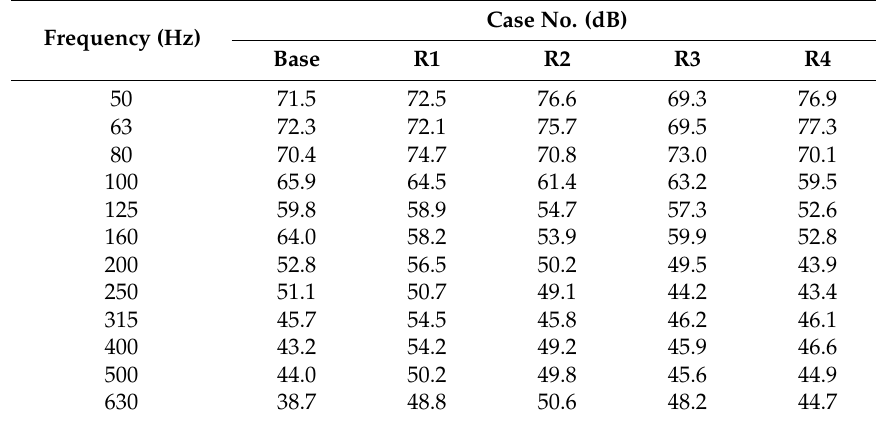
Table 15. Bang machine’s test results in 1/3 Octave bands.